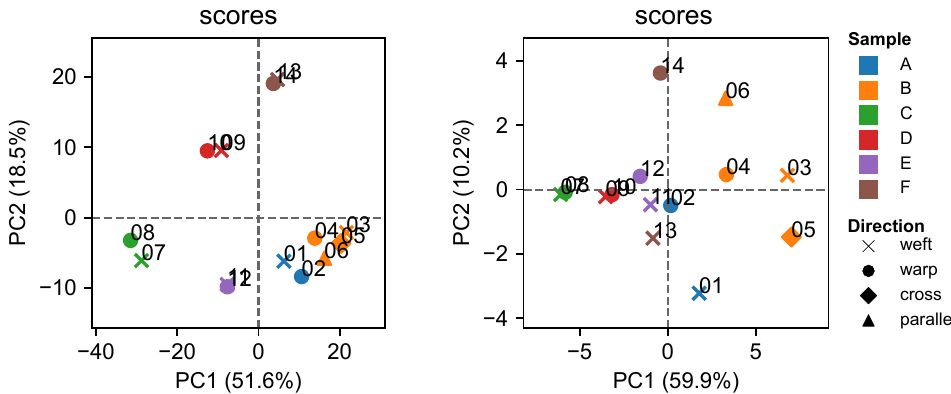
Figure 7. Consonance analysis (scores)—sensory and delta power (horizontal unfolding) . The left scores plot corresponds to the sensory data and the right corresponds to delta power.